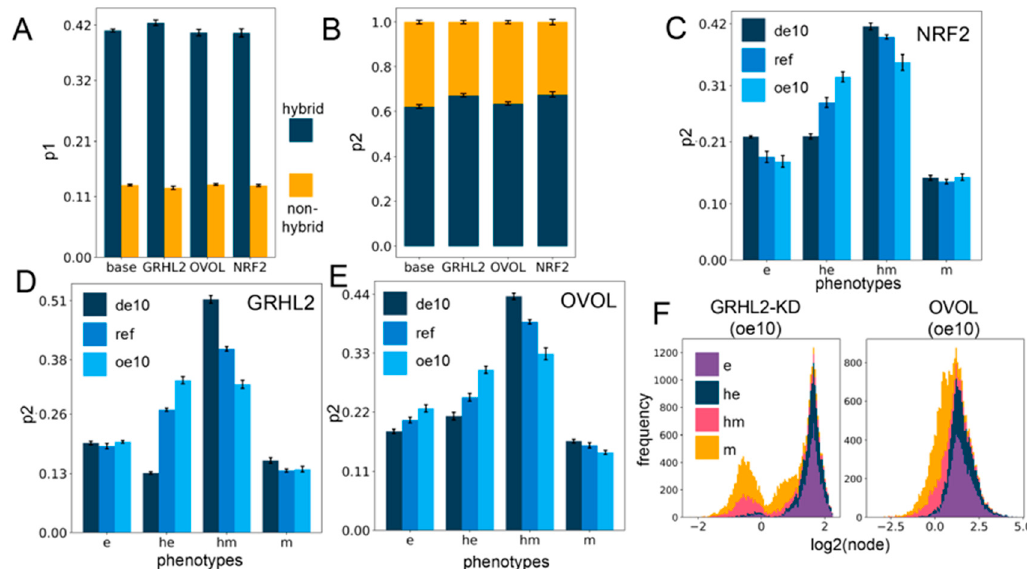
Figure 4. PSF motifs maintain the association between hybrid E/M states and stemness. ( A ) Sum of p1 values for the two hybrid (he, hm) and two non-hybrid (e,m) phenotypes, for different circuits including PSFs. ( B ) Same as ( A ) but for p2. ( C – E ) p2 values for four phenotypes for cases of over-expression and downregulation of each of the PSFs individually: NRF2 ( C ), GRHL2 ( D ), and OVOL ( E ). ( F ) Stacked expression histograms (colored in accordance with the phenotypes) showing the change in the PSF node distribution in the GRHL2-KD circuit (GRHL2-KD) (left panel) vs. the OVOL circuit (right panel) at 10-fold over-expression. GRHL2-KD involves knockdown of the activating link from GRHL2 to miR-200, causing the only difference between the two presented circuits to be the nature of the self-link of the PSF node. All other links remain the same. (de10: 10-fold down-expression, ref: Reference unperturbed circuit, oe10: 10-fold overexpression) ( A – E ): The values are averaged across replicates and the error bars represent the across-replicate standard deviations; refer to Table S8 in Supplementary Section S2.5 for the statistical testing of these